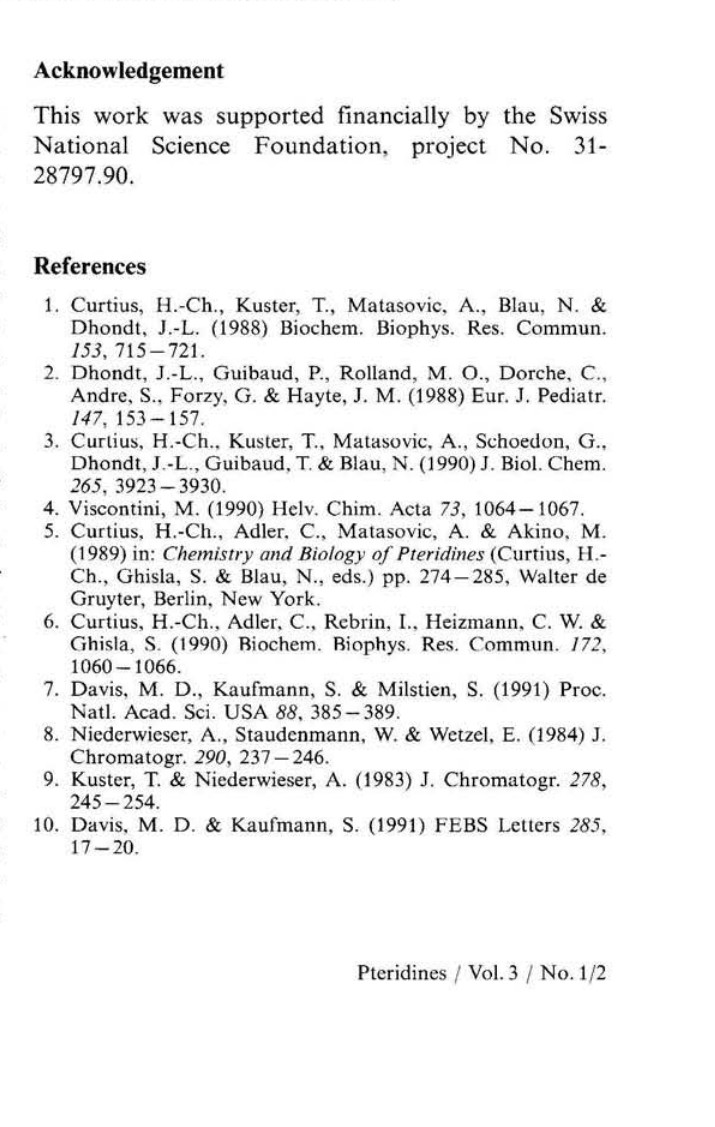
Figure 2. Inhibition of the phenylalanine hydroxylase reaction by L-tetrahydroprimapterin. Determination of inhibition type. Lineweaver Burke plot at varying concentrations of inhibitor: 0 μΜ up to 20 μΜ L-tetrahydroprimapterin.